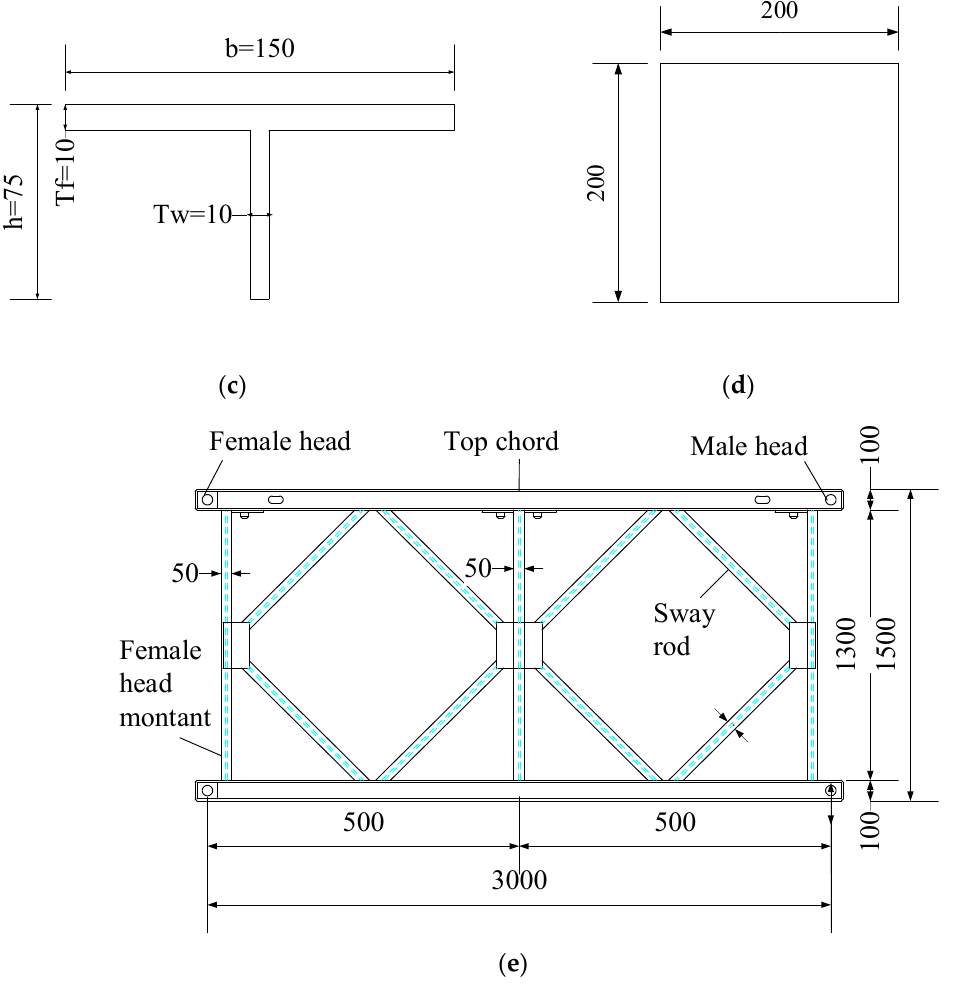
Figure 4. Material dimension details (unit: mm): ( a ) I100-I beam. ( b ) I56b-I beam. ( c )T75 steel. ( d ) Steel sleeper beam (B200 × 200 × 480). ( e ) A section of Bailey.